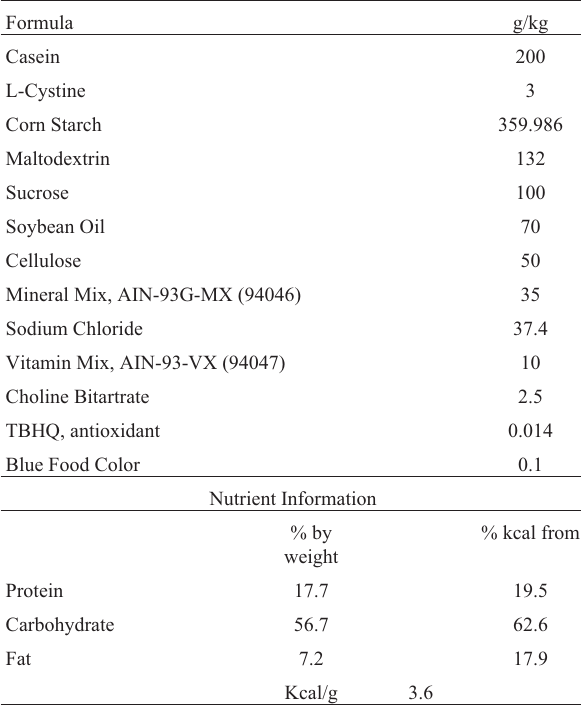
Table 2 - 4% NaCl Diet: TD.150218 AIN-93G